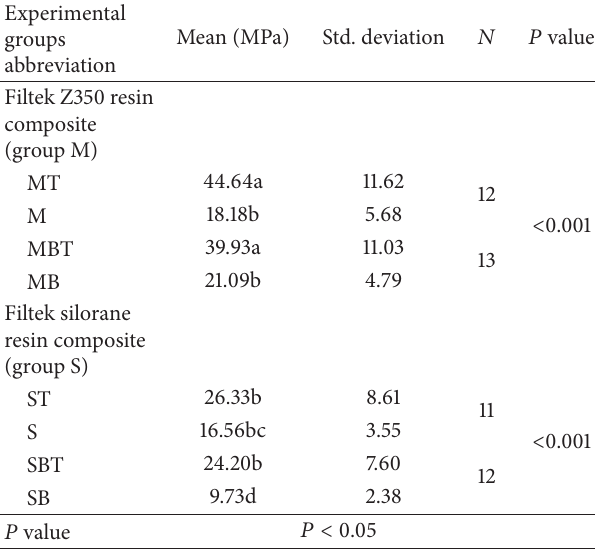
Table 2: Mean values and respective standard deviations of micros- hear bond strength (MPa) in experimental